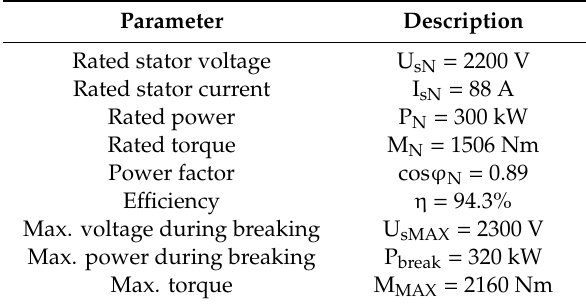
Table 6. DKLBZ 0910-04 type traction motor